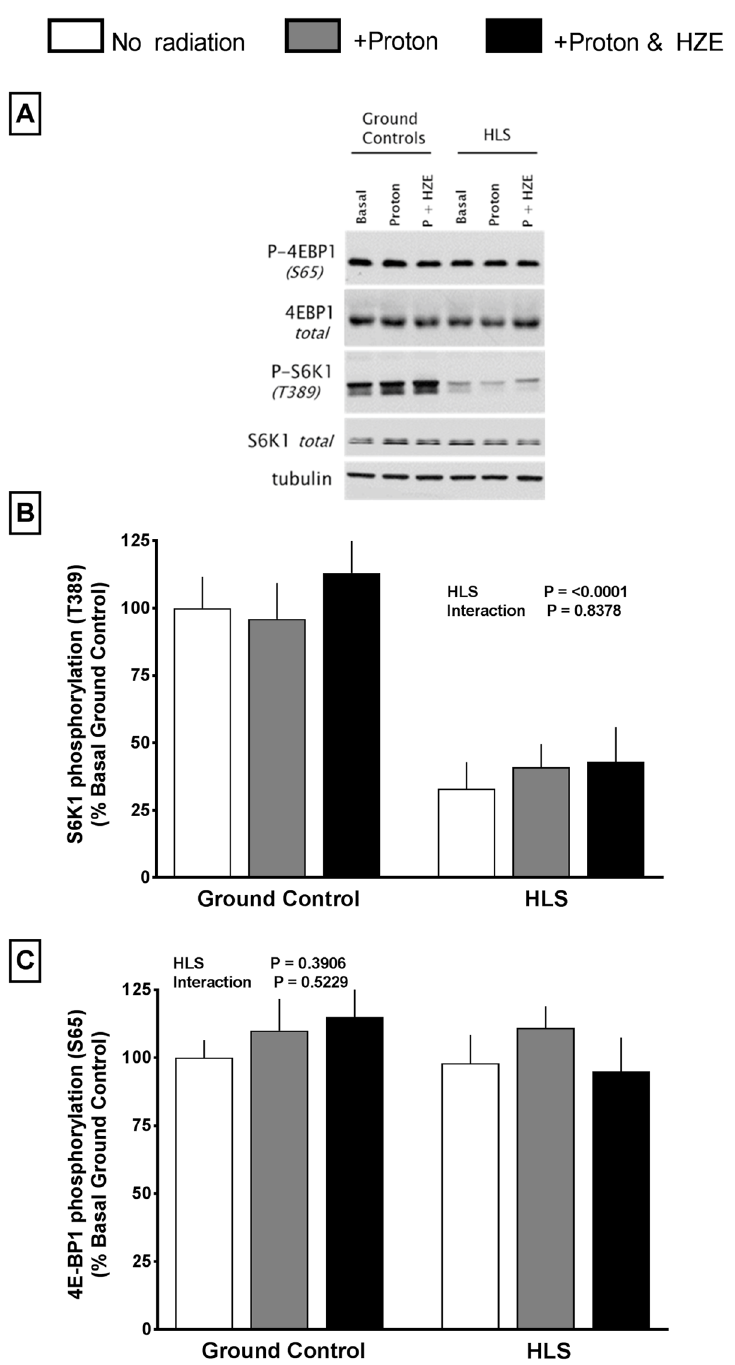
Fig 6. Effect of HLS and radiation on phosphorylation of mTOR downstream regulators 4EBP1 and S6K1 measuredvia Western blot analysis. Top panel (A) is a representative Western blot for phosphorylated and total S6K1 (B) and 4E-BP1 (C) in muscle from each of the six experimental groups; tubulin is also includedto demonstrate equal protein loadingall groups. All samples were run on the same gel. Bar graphs represent averagevalues at conclusionof study and are normalized to GC group. Valuesare means ± SEM; n = 14-18/group, (p < 0.05).